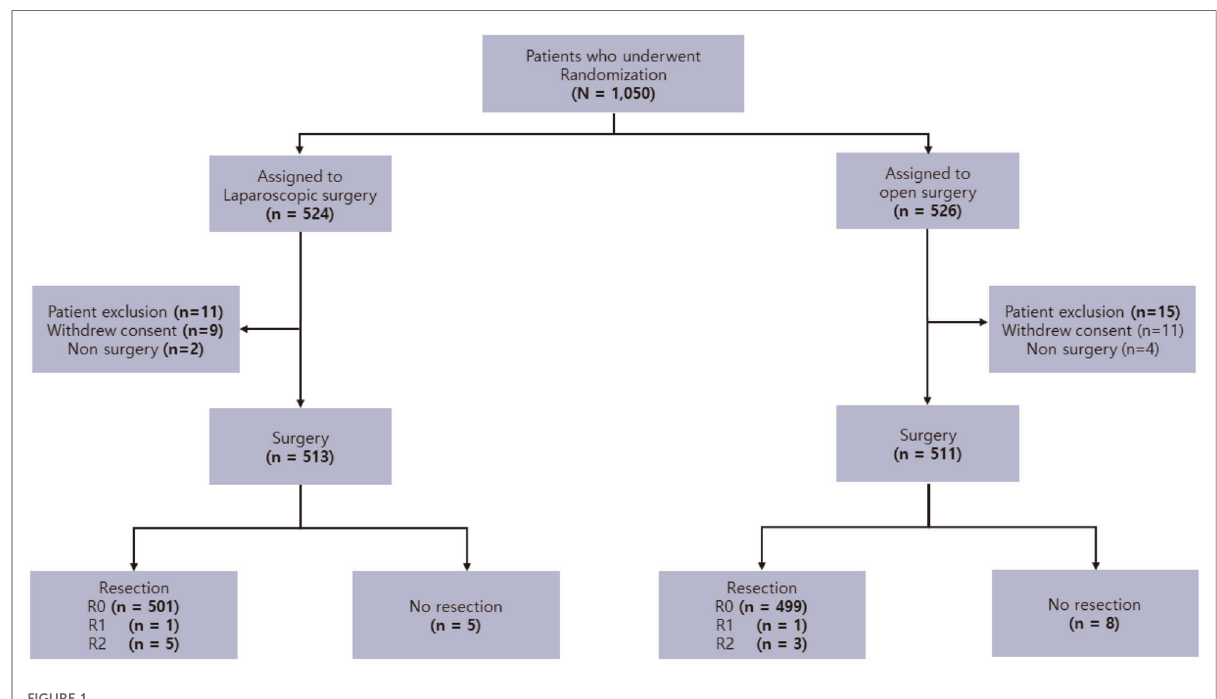
FIGURE 1 Schema showing npatient